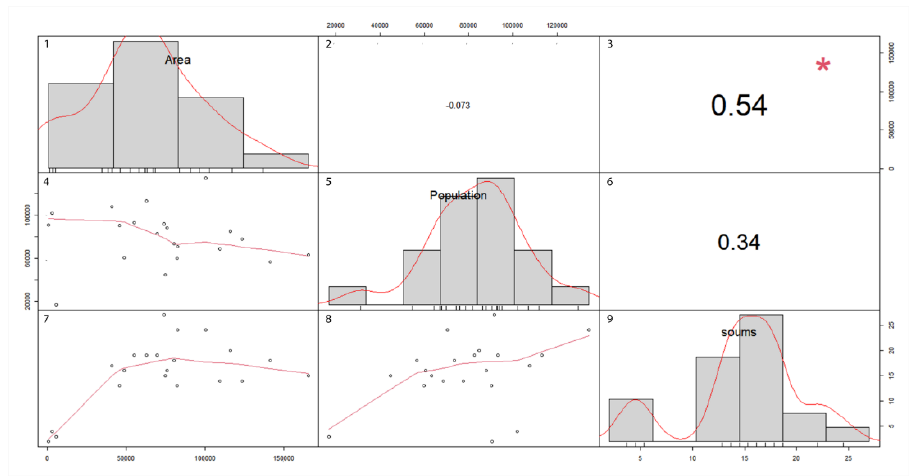
Figure 10. Correlation big data analysis for each province in Mongolia.